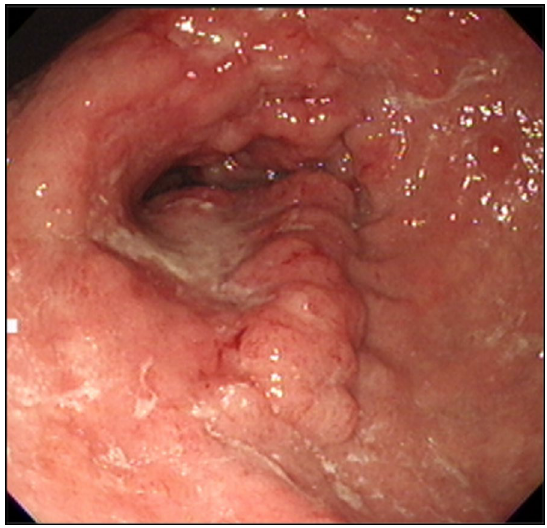
Fig. 3 Computed tomography revealed enhanced wall thickening in the lesser curvature of the stomach from the antrum to the middle of the body (red